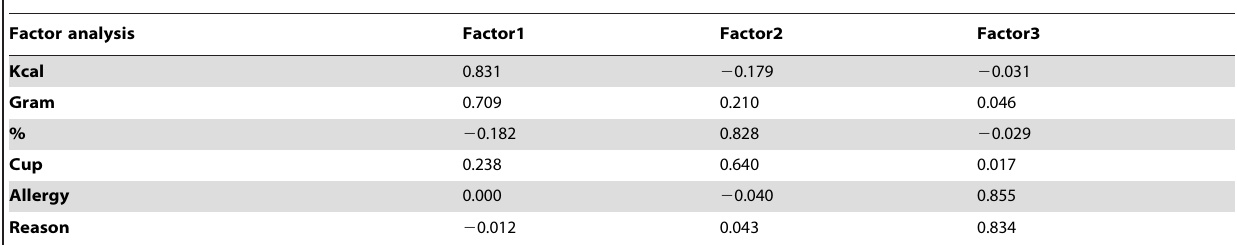
Table 4. Factor analysis of the NVS-J.